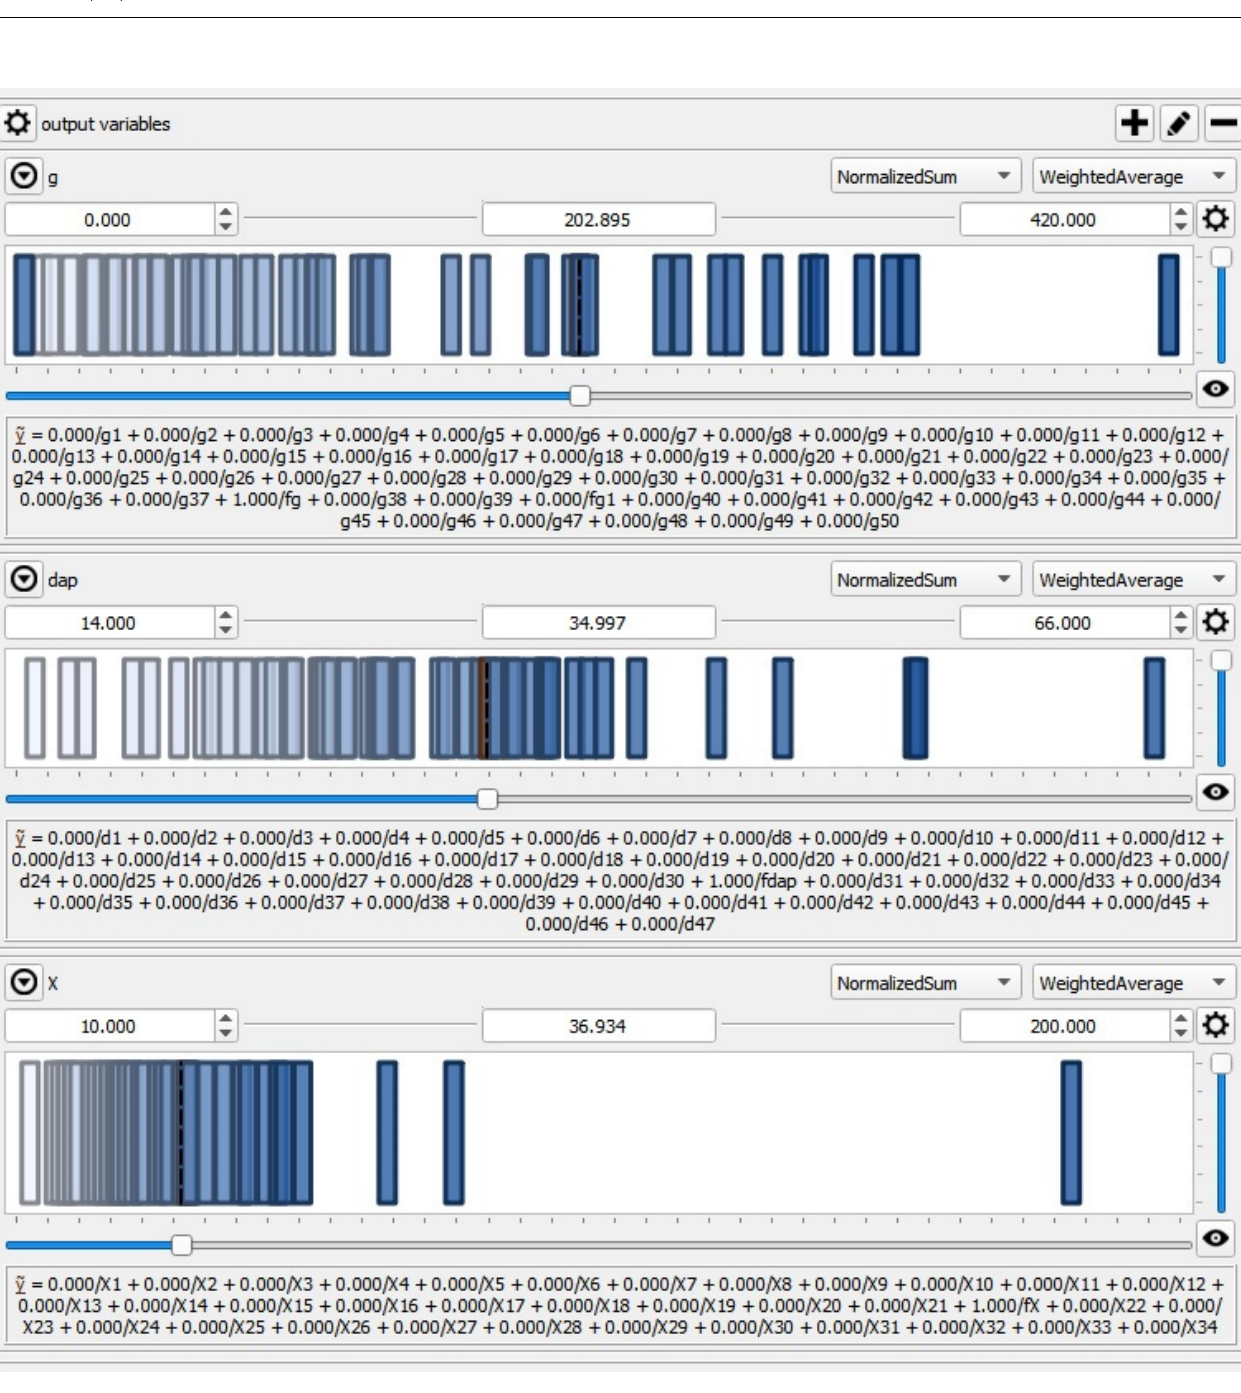
Figure 4. Membership functions for output parameters g, d ap and X (x-axes and y-axes correspond to parameter values from Table 4 and values of membership function, respectively).